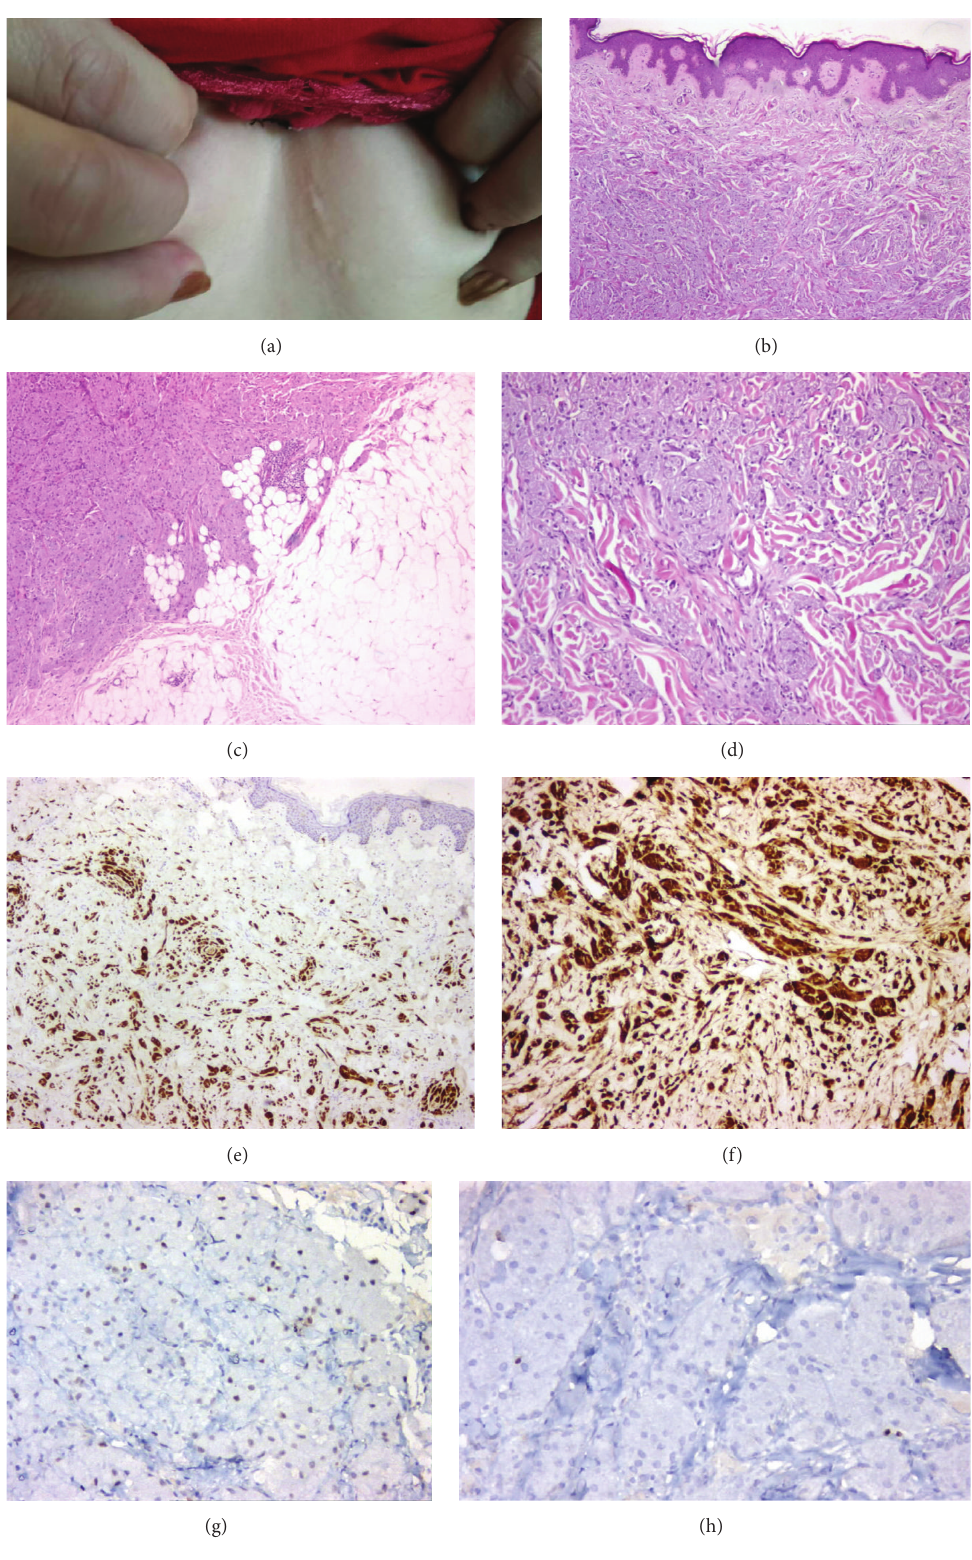
Figure 1: (a) Subcutaneous mass of breast. (b) Minimal acanthosis and epidermal pseudoepitheliomatous hyperplasia (H&E, × 50). (c) Ill- defined tumoral lesion with infiltrative pattern (H&E, × 100). (d) Compact nests and sheets of polygonal tumor cells (H&E, × 200). (e) Tumor cells expressing S100 ( × 100). (f) Tumor cells expressing CD68 ( × 200). (g) Tumor cells weakly expressing p53 ( × 200). (h) Ki-67 proliferation expressing approximately